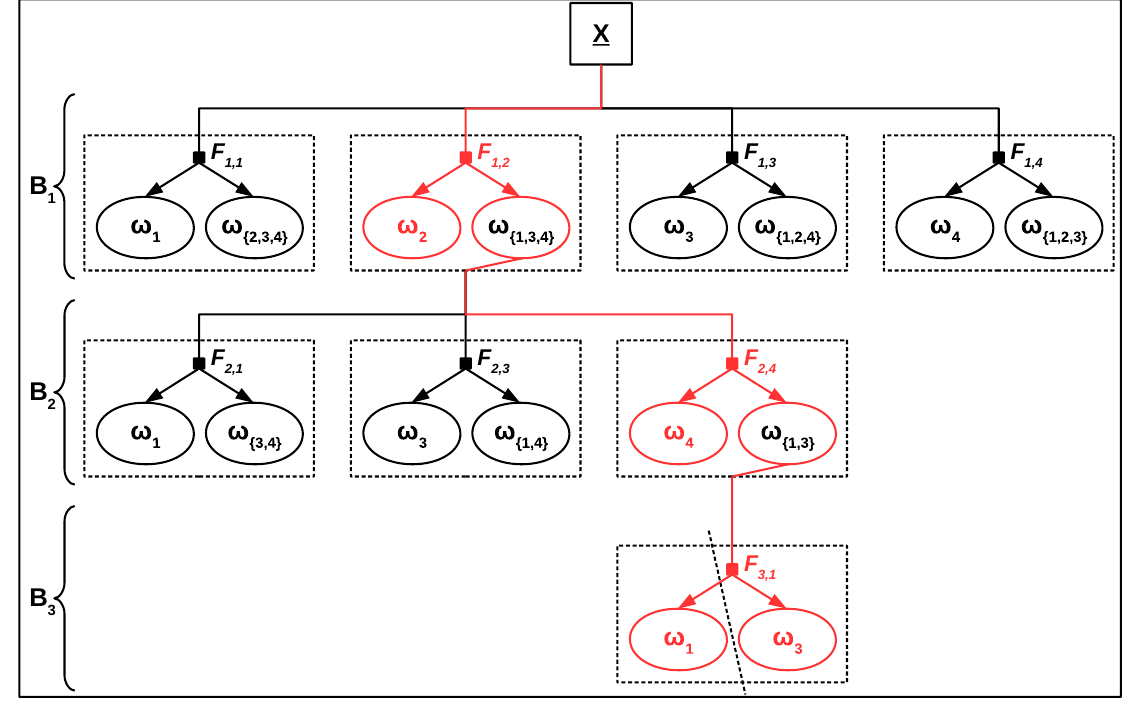
Figure 3. Design stage of decision tree for a four-class problem. The optimal path through the tree is highlighted in red and may differ from the decision-tree (DT) architecture shown in Figure 2. Sequential Forward Feature Selection (SFFS) is run at each black square to determine the feature set F ij during the design